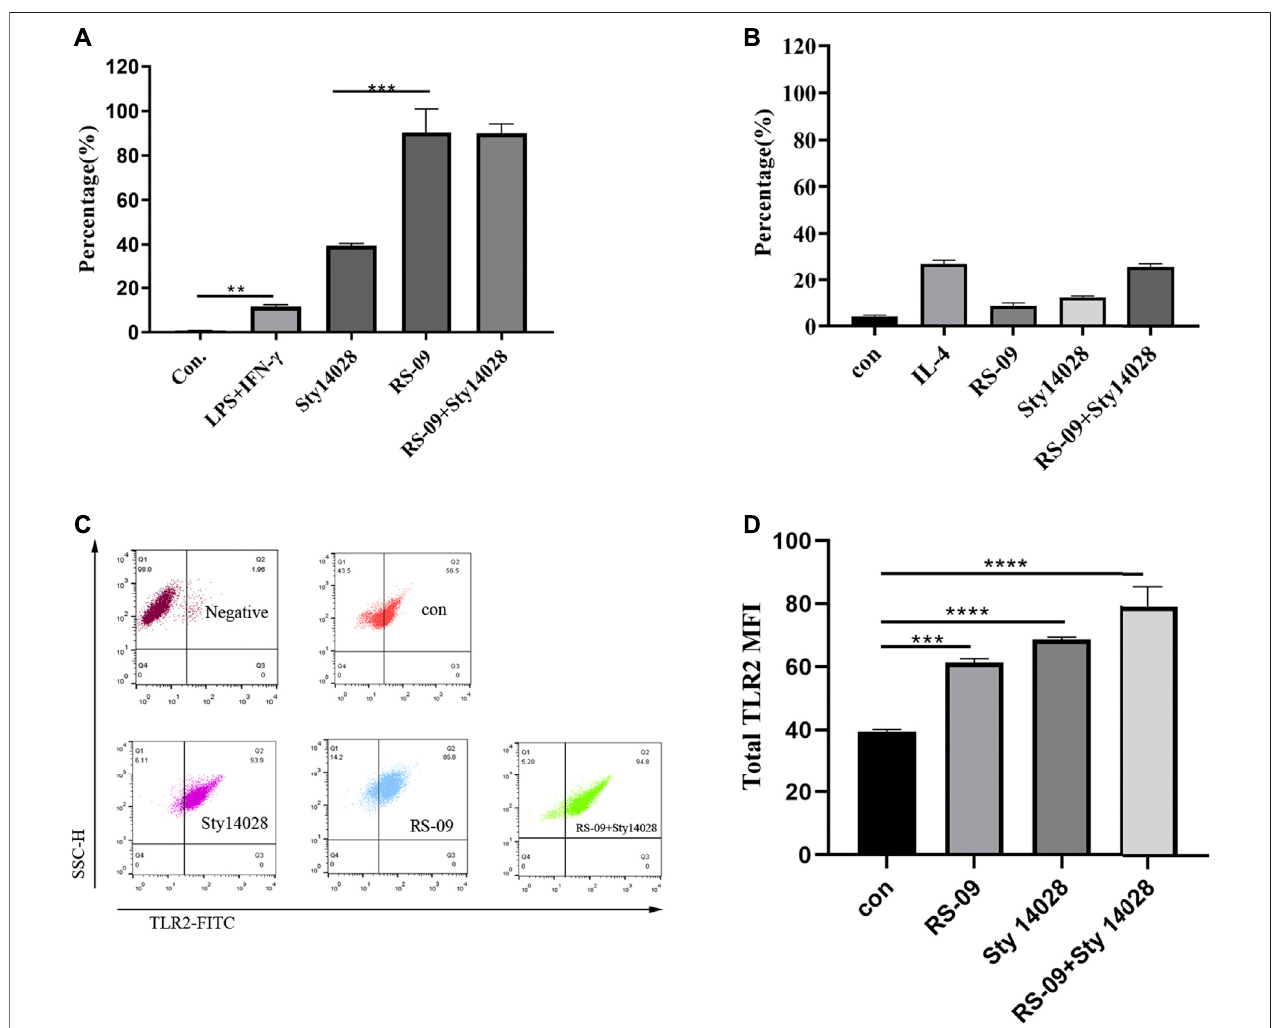
FIGURE 6 | RS-09 stimulates M1 polarization in vitro . RAW264.7 macrophages were differentiated and pretreated with RS-09 for 12 h and then treated with Sty14028for1 h. (A) RepresentativeplotshowingtheeffectofRS-09ontheexpressionoftheM1markerCD11c + CD206 − inRAW264.7macrophages.RAW264.7cells weretreatedwithLPS(100 ng/ml)plusIFN- γ (20 ng/ml)todifferentiateintoM1(M1positivecontrol)macrophages. (B) DetectionofM2macrophagepolarization-related markers by fl ow cytometry. RAW264.7 cells were treated with IL-4 (40 ng/ml) to differentiate into M2 macrophages (M2 positive control). (C) Representative plot showingtheexpressionofTLR2inRAW264.7macrophages. (D) QuantitationofTLR2-positivecellsderivedfromRAW264.7cellsafterdifferentcombinationtreatments for 12 h ** p < 0.01; *** p < 0.001; *** p < 0.0001. Data are the means ± SD of three independent experiments.